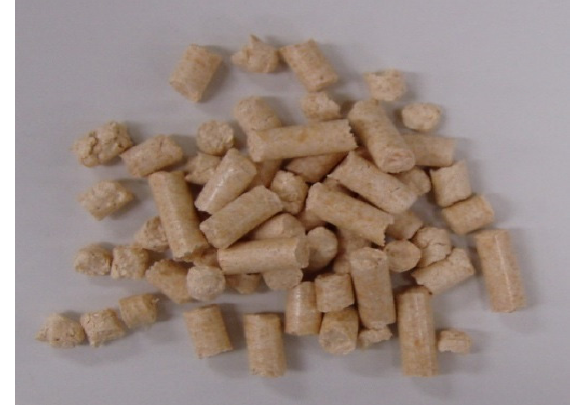
Figure 1. Wood pellets (made from tree